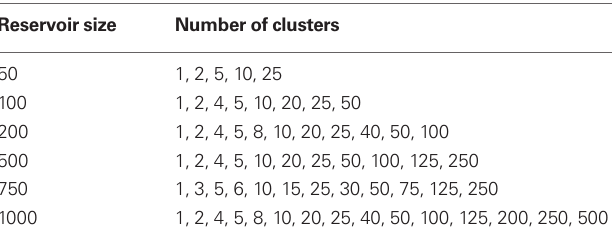
Table 1 | Cluster configurations tested for different reservoir